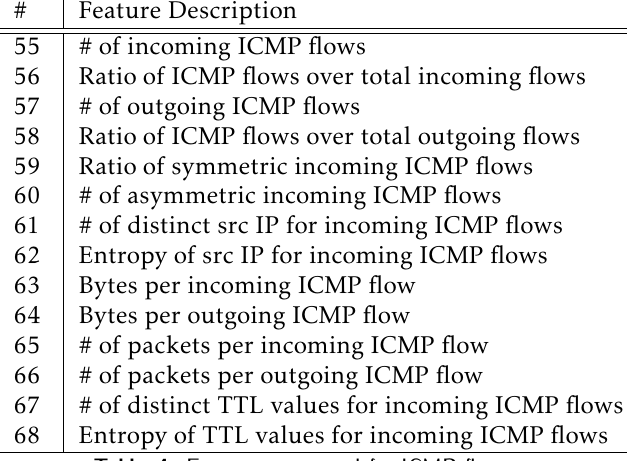
Table 4. Features extracted for ICMP flows